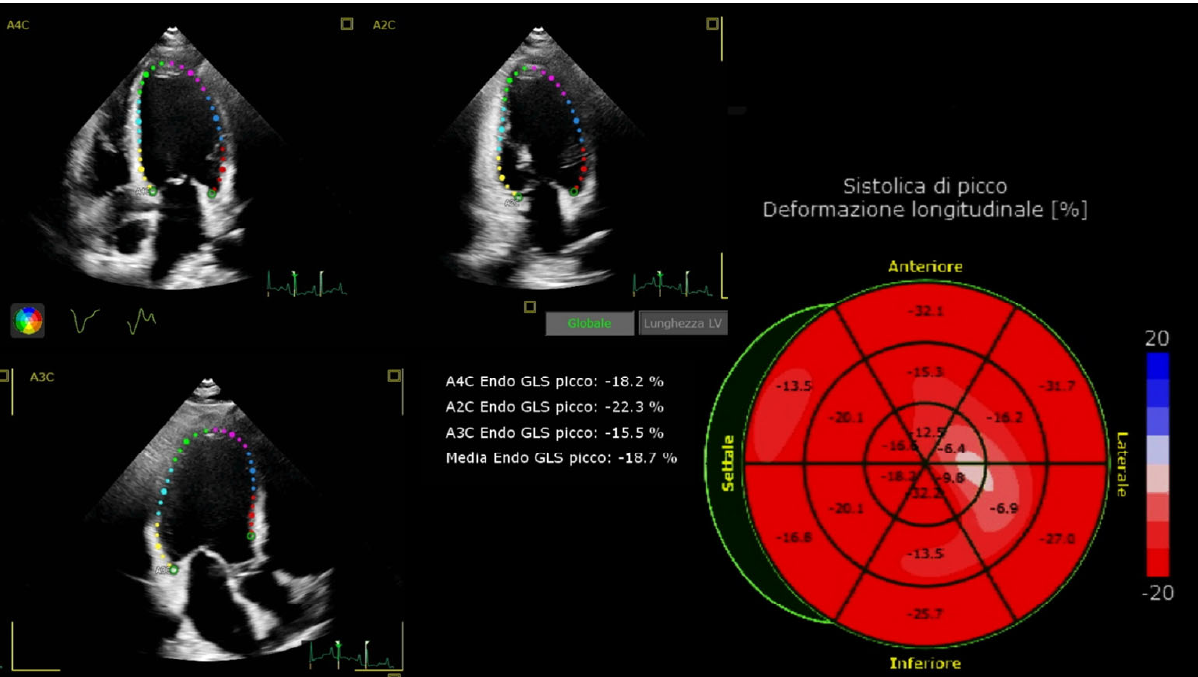
Figure 1. Left Ventricular Global Longitudinal Strain (LV GLS) with speckle tracking echocardiogra- phy (STE) is a helpful tool able to find out a subclinical LV dysfunction in an otherwise normal heart, which may evolve towards diabetic cardiomyopathy. Peak GLS is a negative number and a value in the range of − 20% is considered